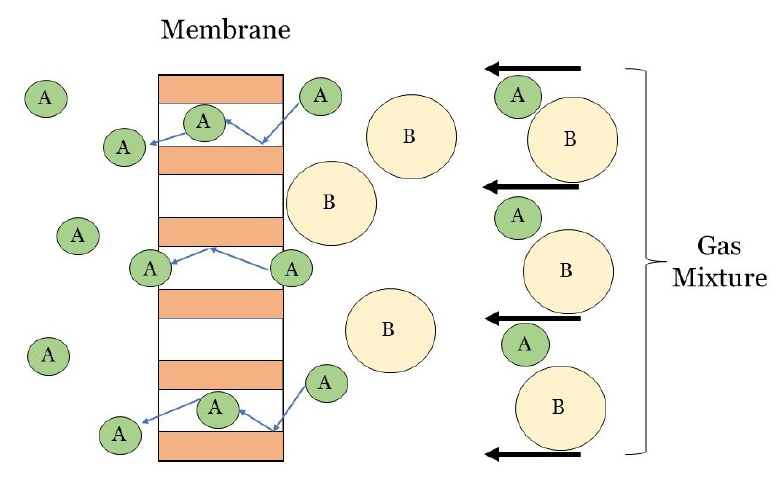
Figure 6. Graphical depiction of the pore flow model, where molecule A crosses the membrane due to a pressure difference. The illustration is not drawn to scale to emphasize the flow through permanent pores